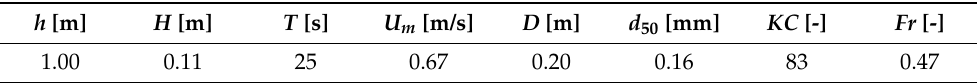
Figure 1. The wave flume and experimental setup [7] used for validation. Table 1. Test conditions in the numerical simulation: h , water depth; H , wave height; T , wave period; U m , maximum value of depth-averaged velocity; D , structure width; d 50 , sediment size, KC = U m T / D , Keulegan-Carpenter number; Fr = U m /( gh ) 0.5 , Froude number.